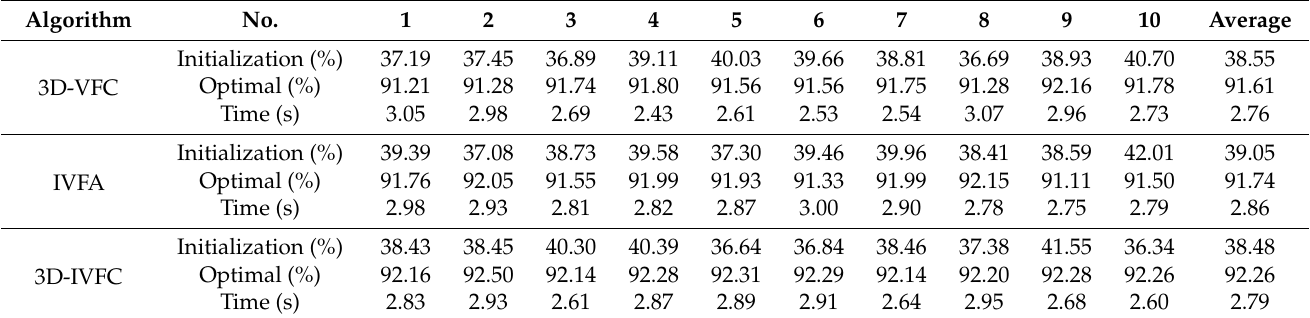
Table 3. Comparison of algorithms for coverage results of central